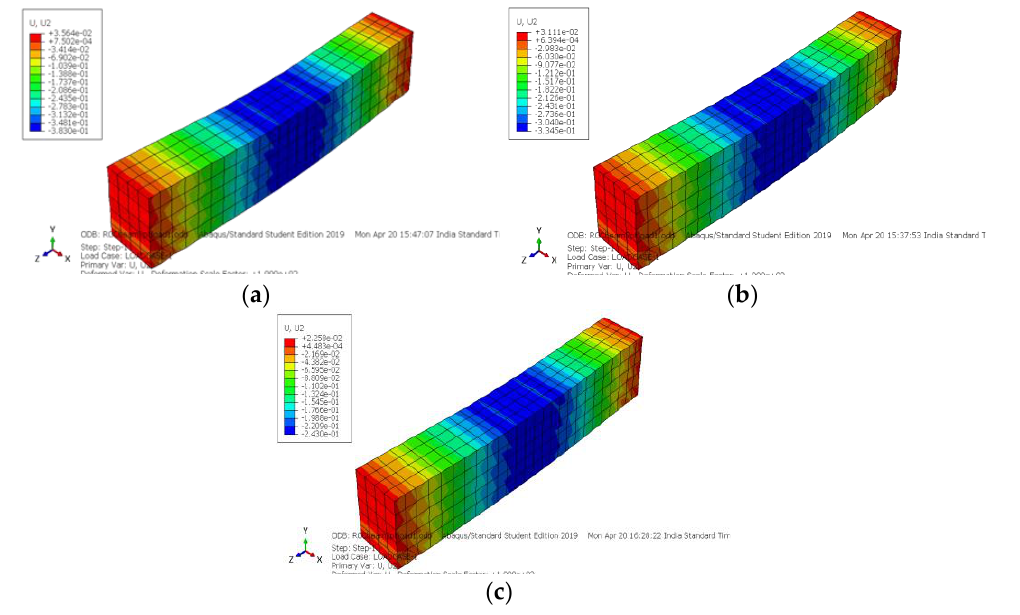
Figure 18. Deflection patterns from ABAQUS. ( a ) 0% bacteria (conventional concrete). ( b ) 75% copper slag with 1% bacteria. ( c ) 75% copper slag with 2% bacteria. The deflection value of 0.38 mm is represented in the table by the blue value. The maximum deflection of Beam 2 was 0.33 mm, and the blue value in the table corresponds to a deflection of 0.345 mm. The maximum deflection of Beam 3 was 0.26 mm, whereas the blue value in the table indicates a deflection of 0.24